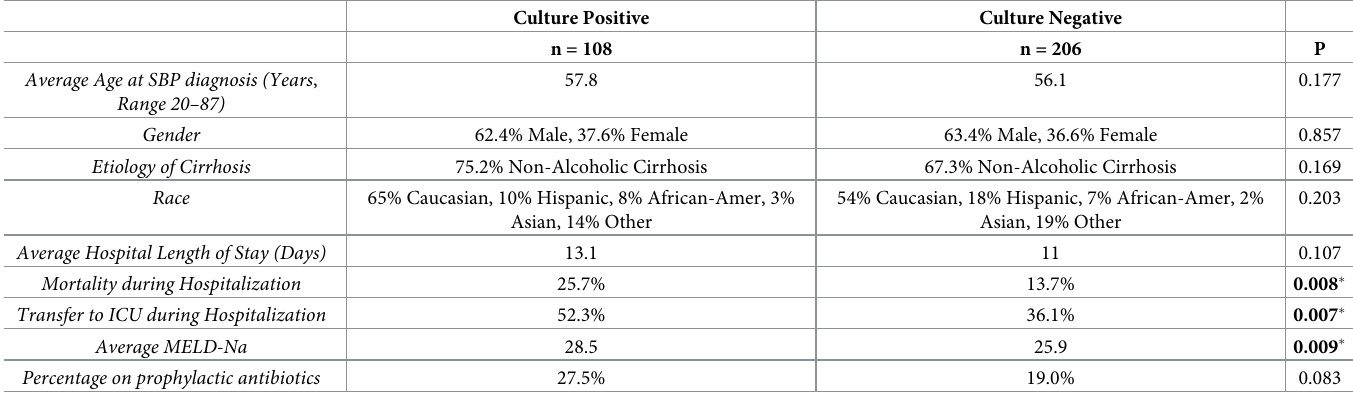
Table 1. Descriptive statistics of patients in the SBP cohort.